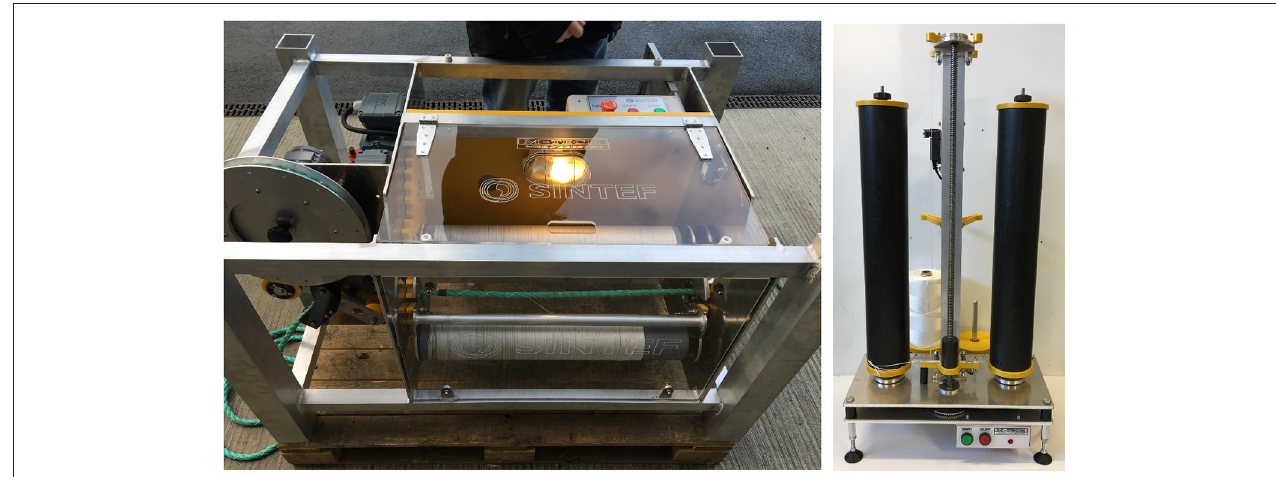
FIGURE 9 | (Left) The rope spinner that spins seedling substrate onto carrier rope. (Right) The automatic rewinder that winds seedling substrate onto cylinders for pre-growth of seedlings.